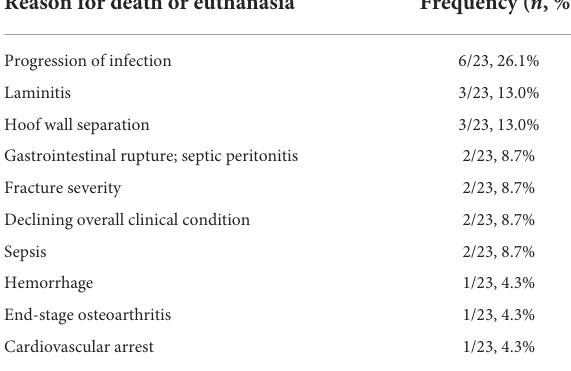
TABLE 5 Reason for death or euthanasia in hospital for 23